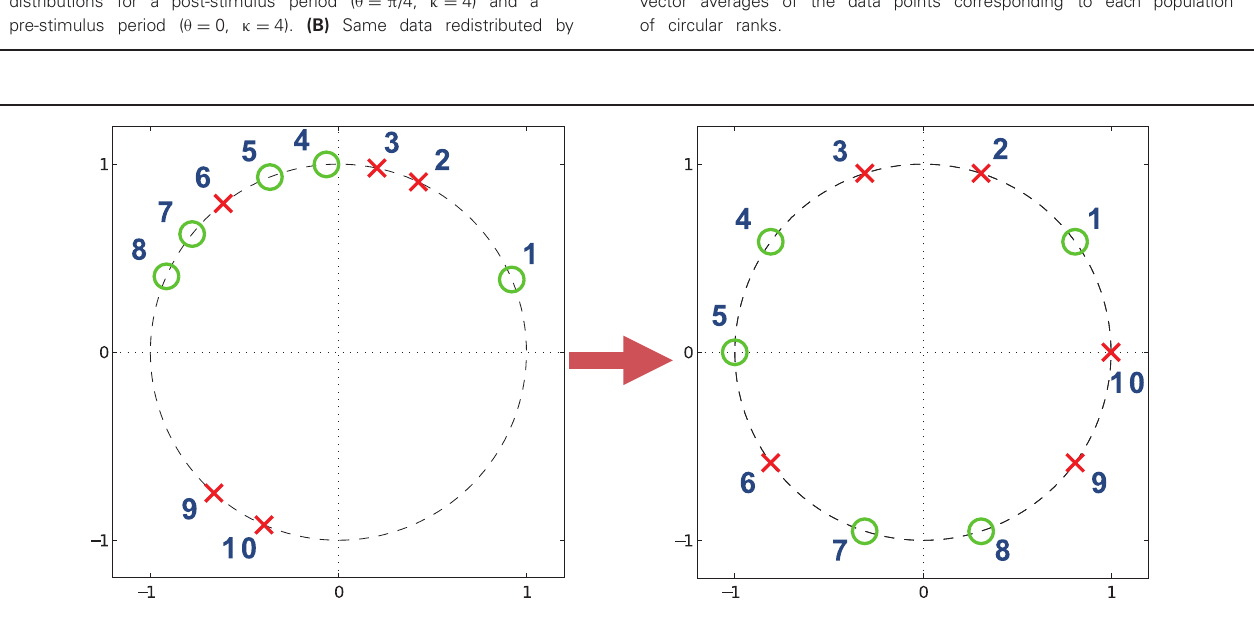
FIGURE 6 | An example of circular rank statistics. The circle on the left shows points before circular ranking whereas on the right the points are ranked and repositioned. The numbers indicate the rankings